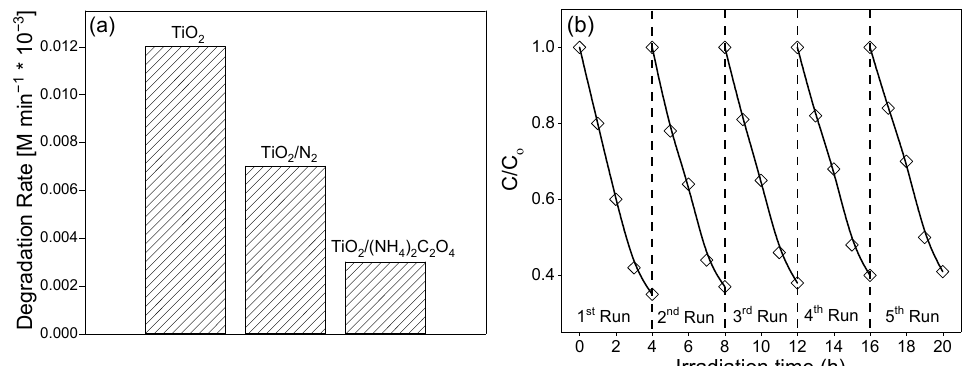
Figure 6. ( a ) Effect of O 2 and hole scavenger on the photocatalytic removal of amaranth and ( b ) effect of recycling on the photocatalytic performance.